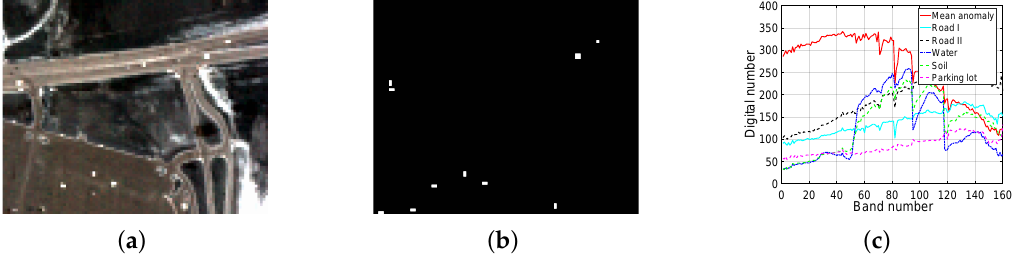
Figure 6. Urban dataset. ( a ) Pseudo-color image; ( b ) Ground-truth map; ( c ) Spectral curves of mean anomalies and main